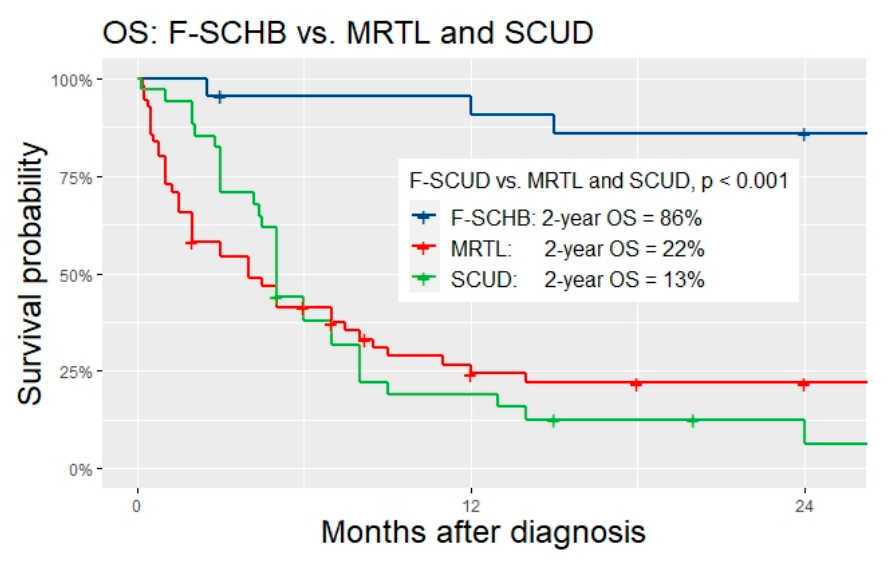
Figure 2. OS of patients with F-SCHD vs. MRTL vs. SCUD.